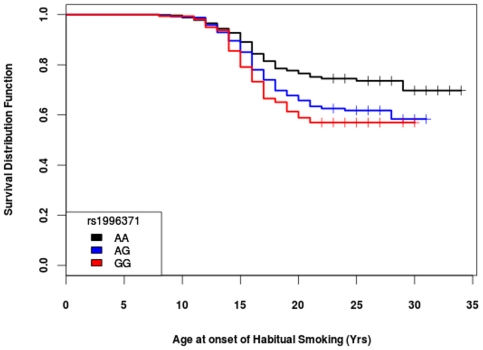
Genotypes of rs1996371 significantly predict age at onset of habitual smoking.